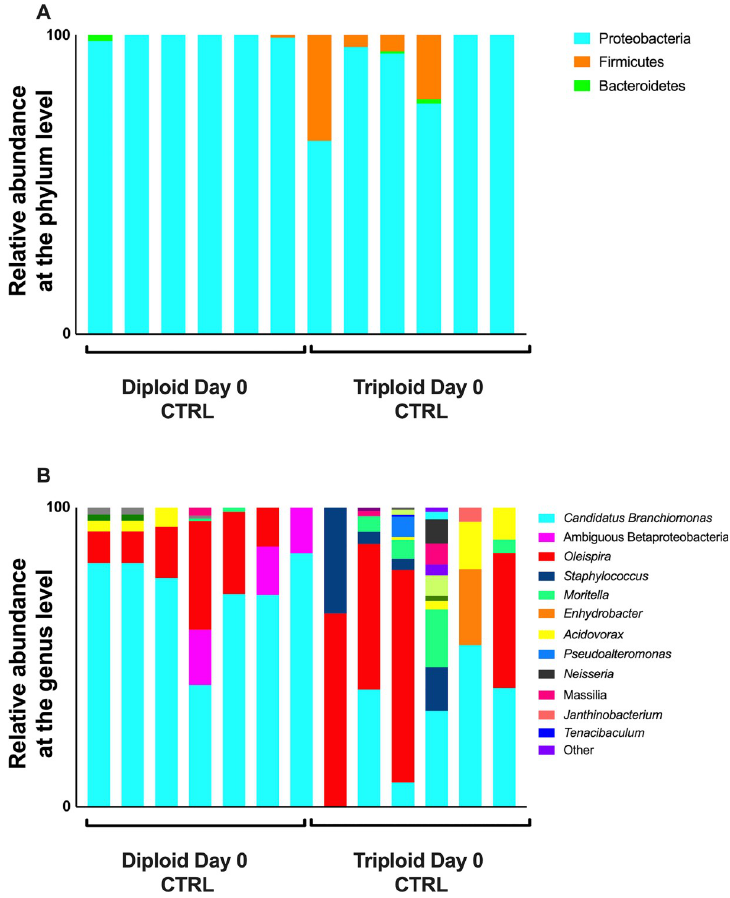
Fig 2. Relative microbial composition in the gills of triploid and diploid Atlantic salmon at the steady state. (A) Relative abundance at the phylum level for triploid and diploid gills at day 0. (B) Relative abundance at the genus level for triploid and diploid gills at day